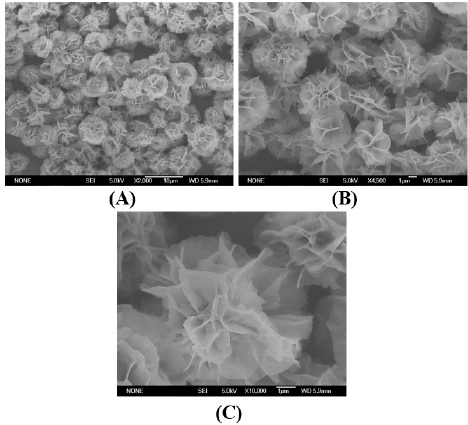
Figure 1. The morphologies of the immobilized samples. ( A – C ): SEM images of the immobilized samples with different enlargement factors.